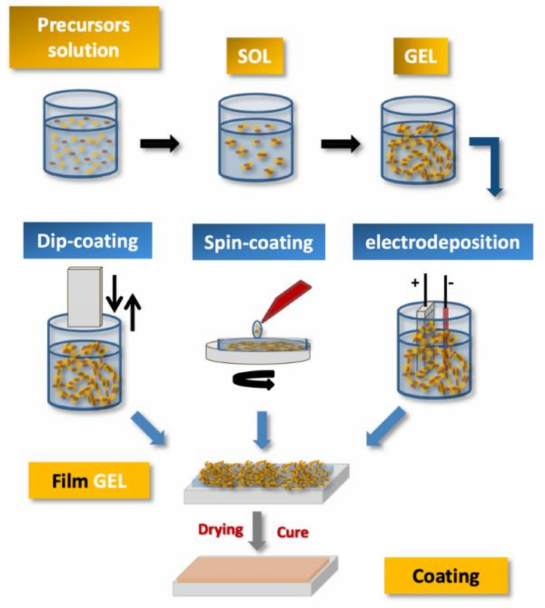
Figure 3. Schematic of steps and processes used to obtain sol–gel coatings